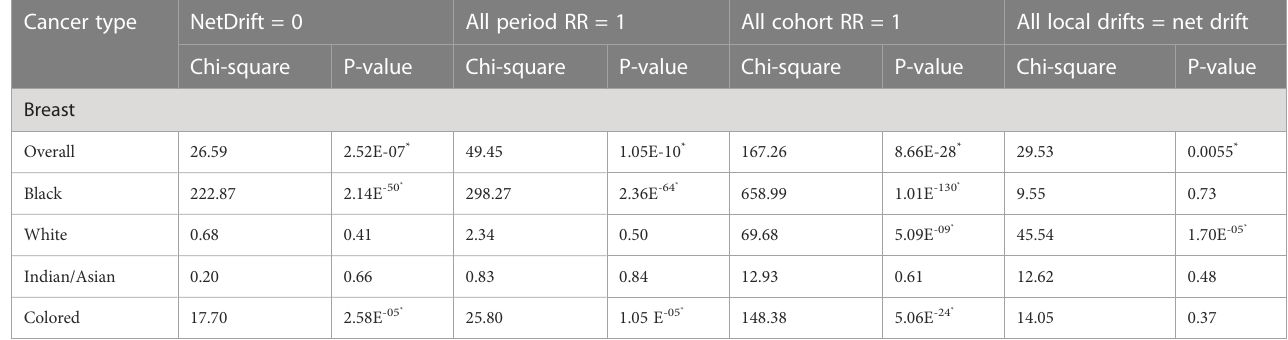
TABLE 3 Wald Chi-square test for estimable functions of the age period cohort model in the overall and ethnic trends of breast cancer mortality in South Africa (1999 – 2018). Cancer